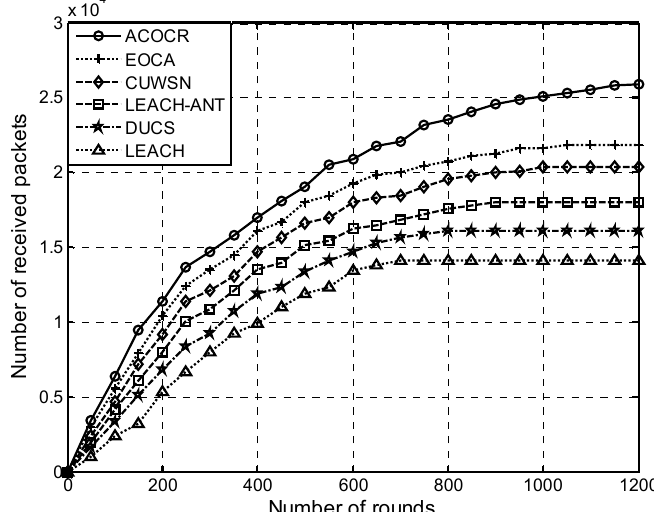
Figure 8. The number of received packets versus the number of rounds for the six algorithms.